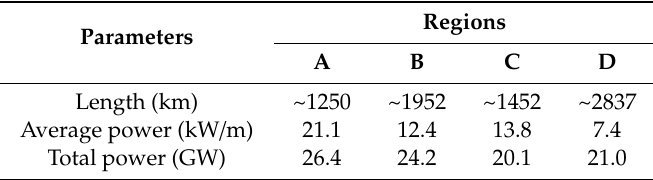
Table 5. Available wave power of the Brazilian coastline.